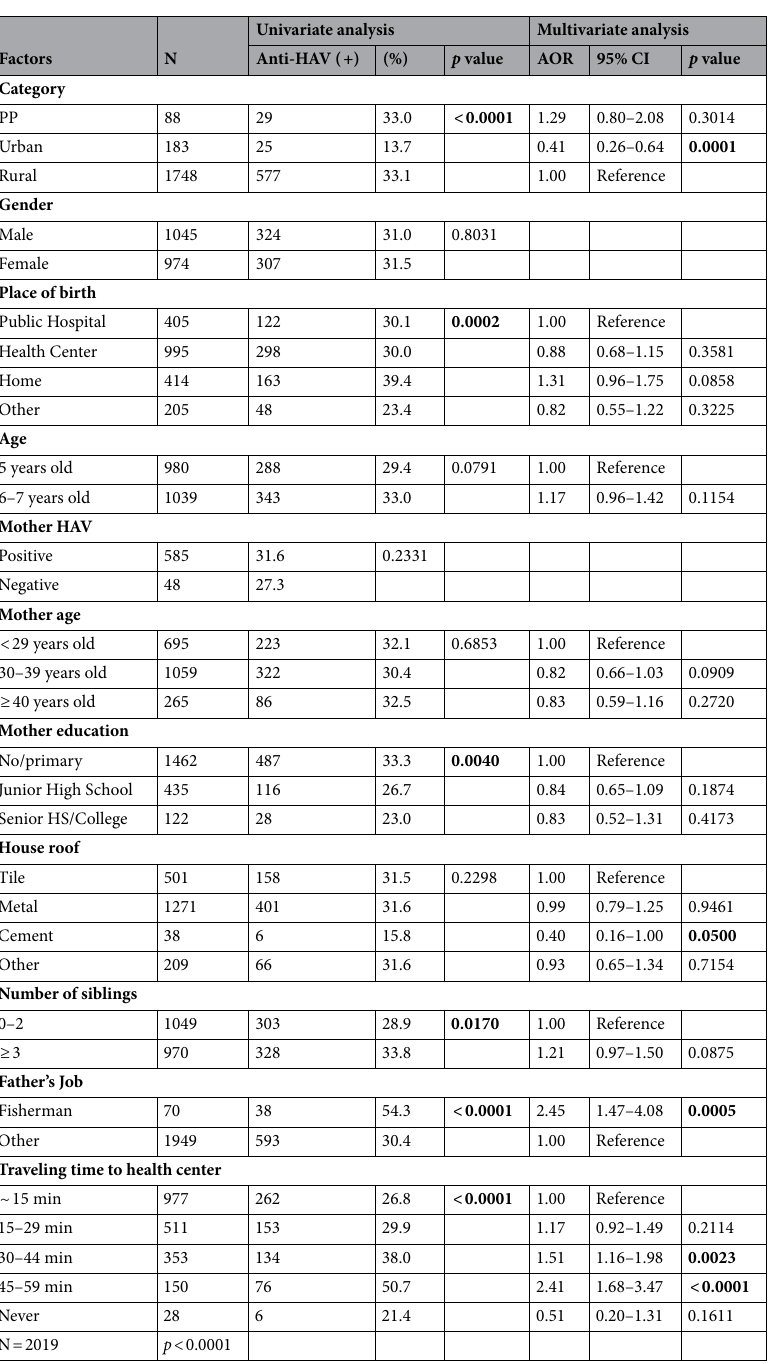
Table 2. Univariate and multivariate analysis on positivity of total anti-HAV among children in Cambodia. Bold values are used to highlight the significant results having significant